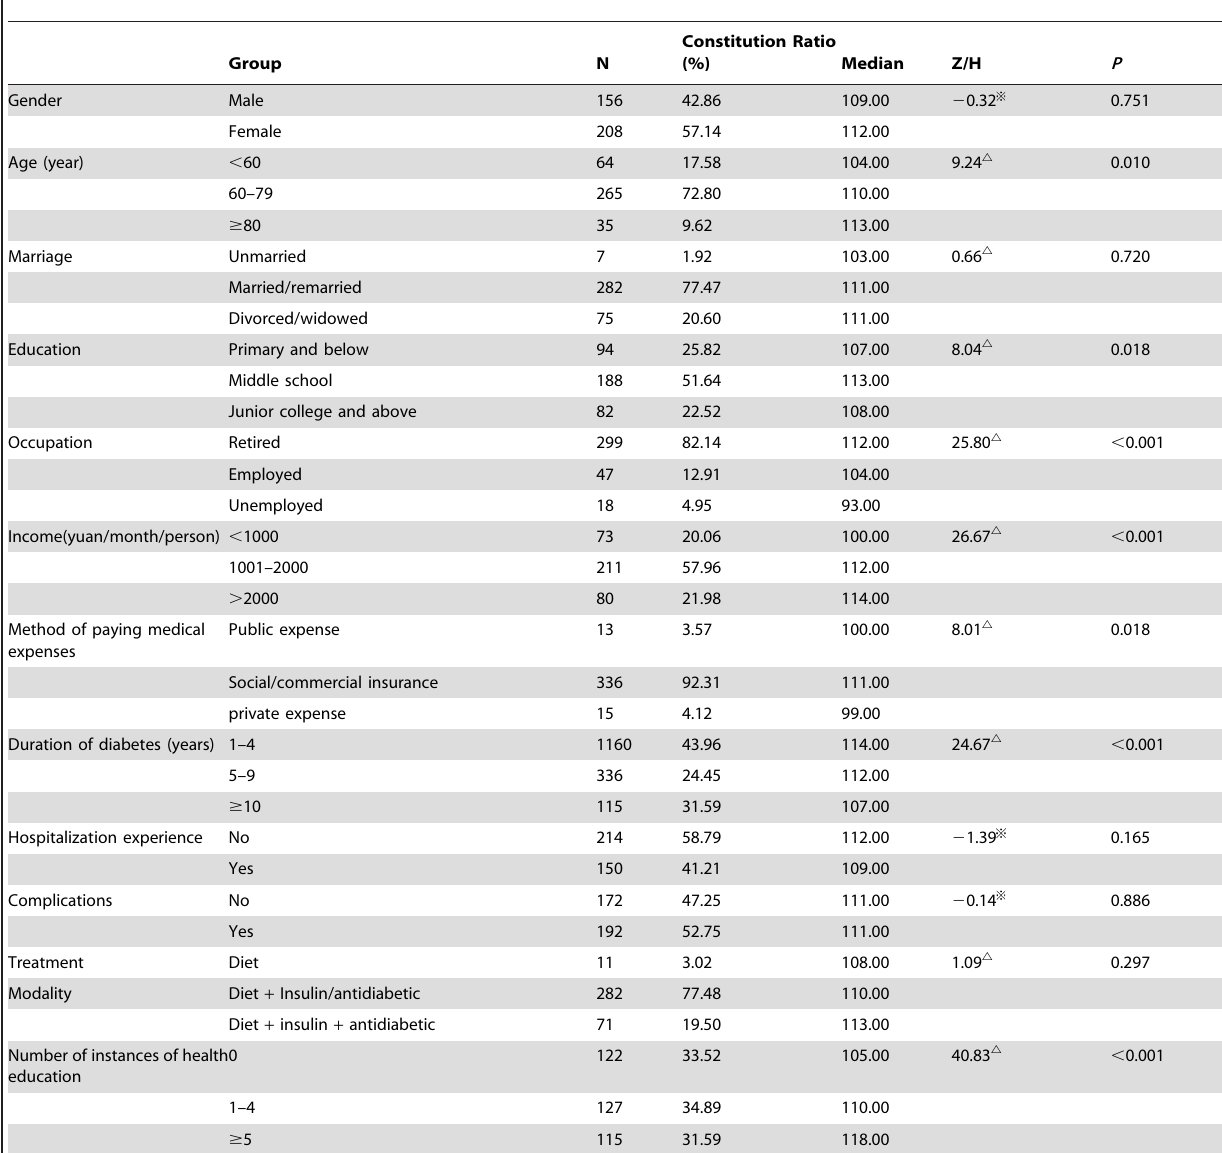
Table 3. Relationship between patient characteristics and self-management